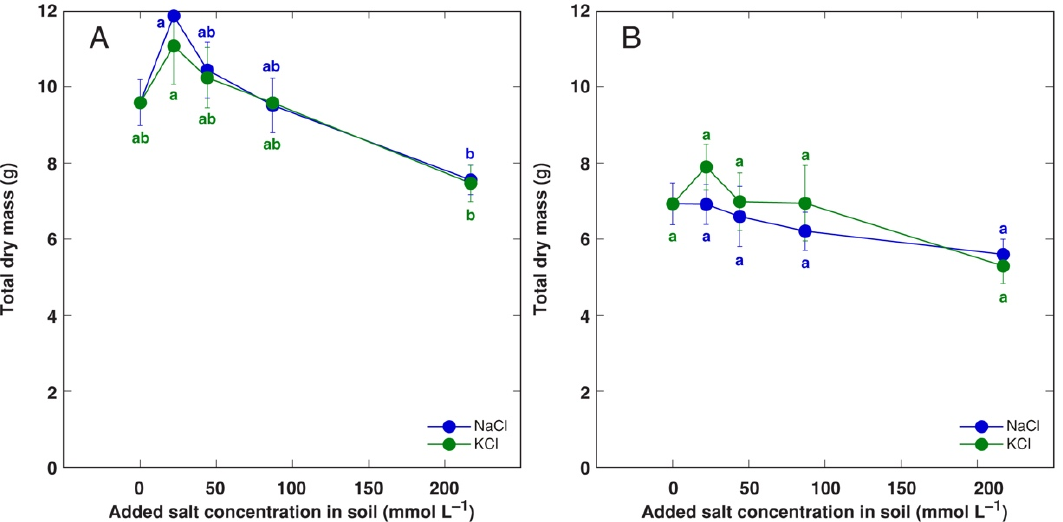
Figure 3. Effect of added NaCl and KCl concentration in soil on total dry mass of Armeria maritima plants from accessions AM1 ( A ) and AM2 ( B ) after 8 weeks of cultivation. Data are means ± SE from 5 replicates. Different letters of respective color between accessions and treatments indicate statistically significant differences ( p < 0.05).